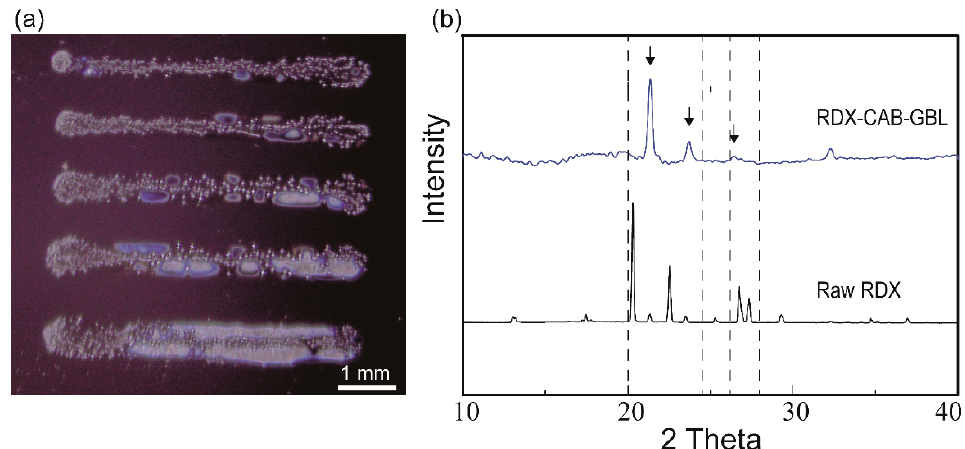
Figure 2. ( a ) Patterns containing RDX were printed on pristine Si wafers by using the formulated RDX-CAB-GBL ink. ( b ) XRD diffraction patterns of the different RDX crystal on Si substrates: raw RDX crystal powder and crystal RDX patterns. CAB: cellulose acetate butyrate; GBL: ɣ -butyrolactone.